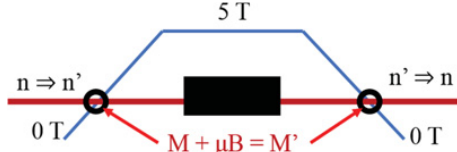
Figure 3. Simplified concept for search for mirror neutron disappearance and regeneration at high magnetic